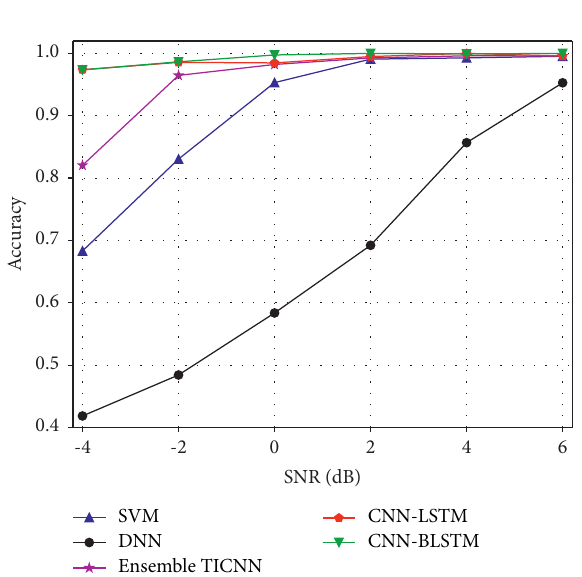
Figure 7: Comparison of accuracy with different SNR